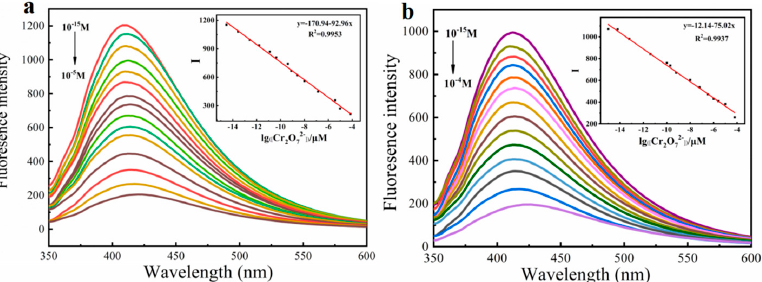
Figure 6. Fluorescence emission spectra of P(Fmoc-Ala-OH) ( a ) 2.5 μ M and P(Fmoc-Thr-OH) ( b ) 4.2 μ M toward Cr 2 O 72 − with different concentrations in DMSO-EtOH, respectively. Inset: Linear plots of their fluorescence intensity against Cr 2 O 72 − concentration. (Ex = 335 nm, 350 nm).